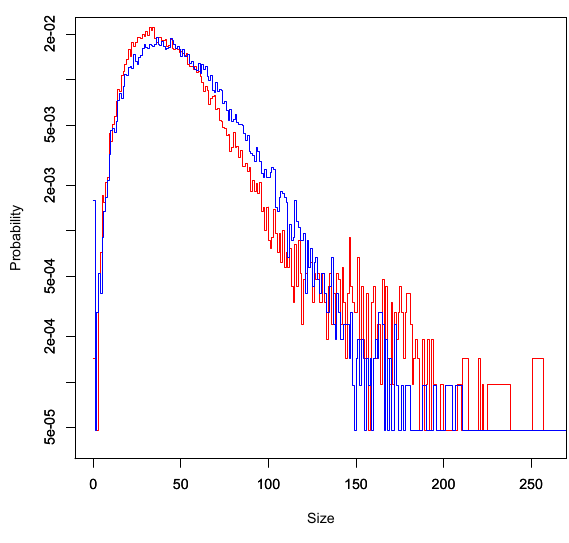
Figure 2: Comparison between daytime ( A 1 in red) and nighttime ( A 2 in blue) arrival distributions.